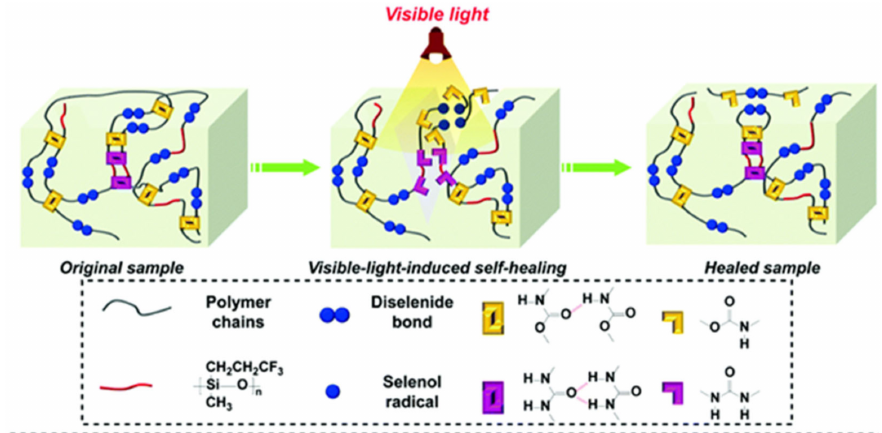
Figure42. Cartoonrepresentationofthehealingprocessofpolymerfilmsinvisiblelight. Reproducedfrom[201] with permission from The Royal Society of Chemistry.